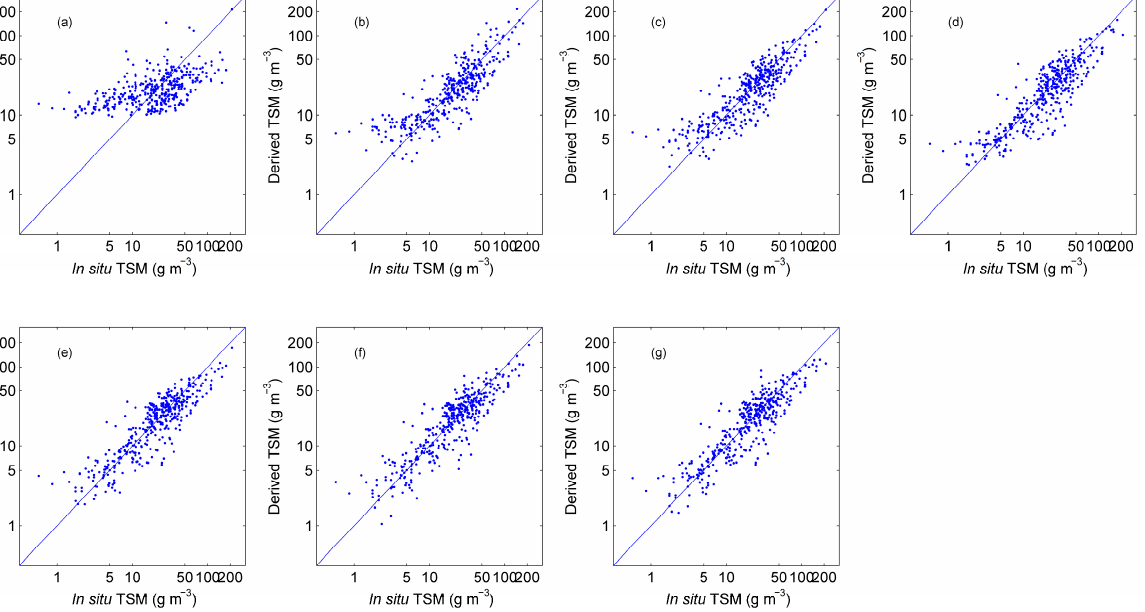
Figure 4. The scatter plots of the derived suspended sediment concentrations and the measured suspended sediment concentrations. The derived total suspended matter (TSM) concentrations in ( a – f ) and ( g ) were obtained from Equations (1) to (7),